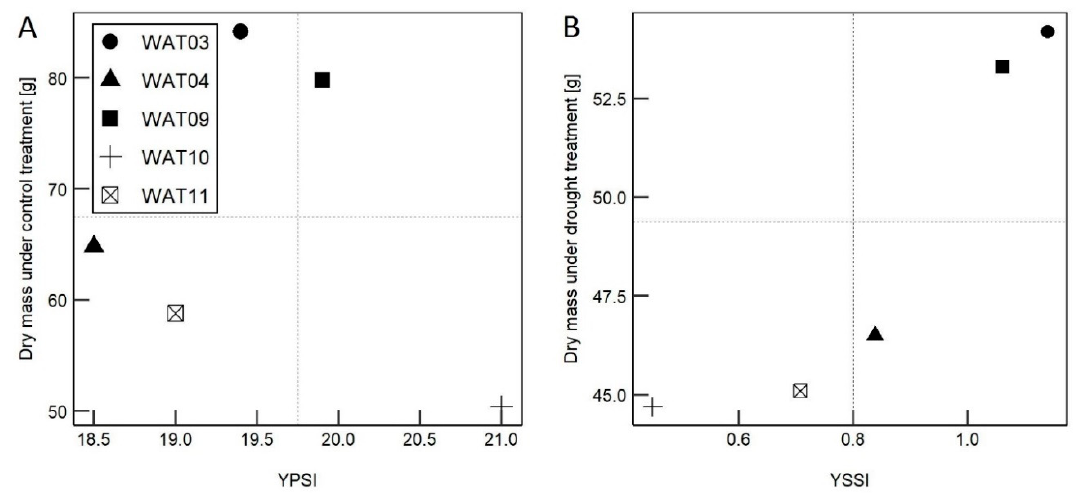
Figure 6. The values of the yield potential score index (YPSI) versus above-ground biomass under control conditions ( A ), and the yield score stress index (YSSI) versus above-ground dry biomass under drought stress ( B ) for each genotype.